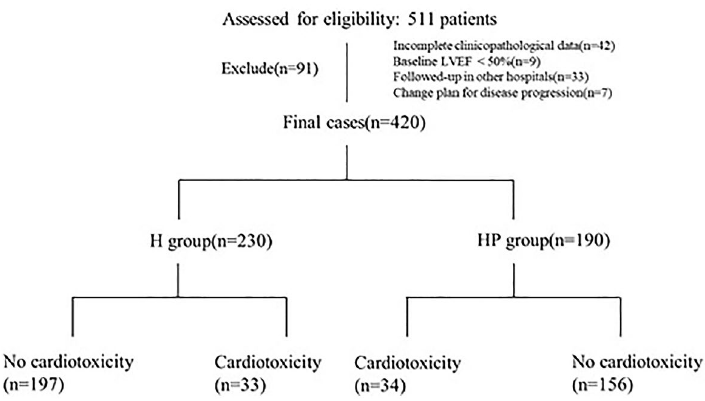
Figure 1. The flowchart of the study. ( H trastuzumab, HP trastuzumab and